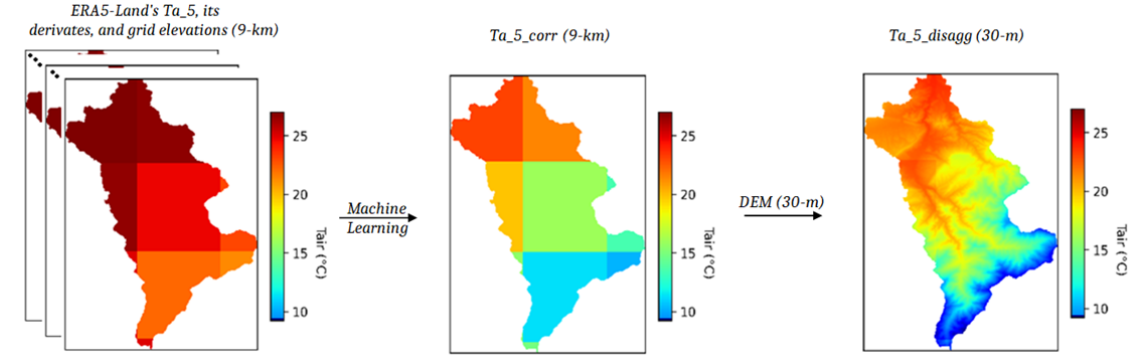
Figure 11. High-resolution temperature mapping of mountainous regions using machine-learning- based downscaling of ERA5-Land’s T2m data. Example showing Xgboost in action across the Rheraya basin on 10 October 2021, at 11 a.m., after the initial calibration of the